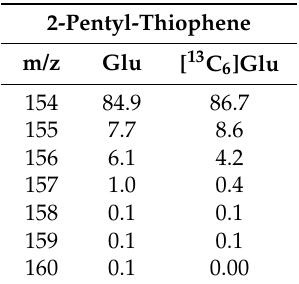
Table 7. Isotope ratios (%) of selected sulfur volatiles from the reaction of [ 13 C 6 ]glucose, cysteine, and